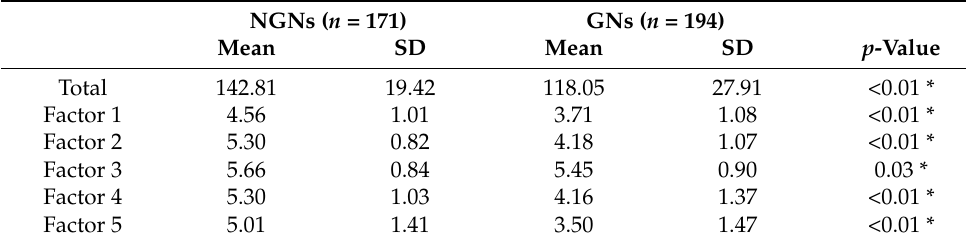
Table 4. Known-group validity of the NDEC